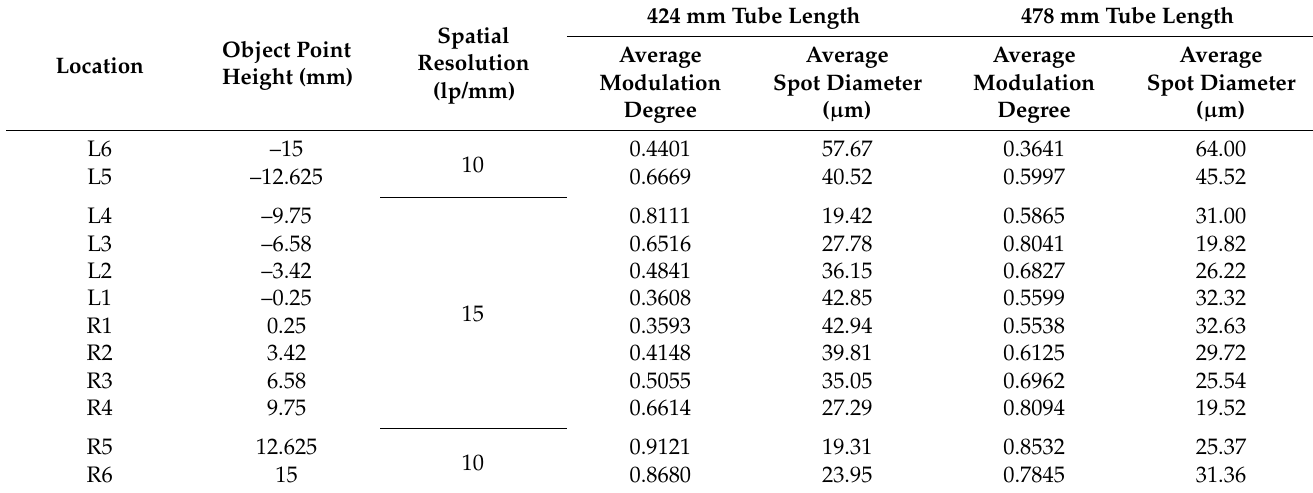
Table 2. Data of different tube length with planar screen.